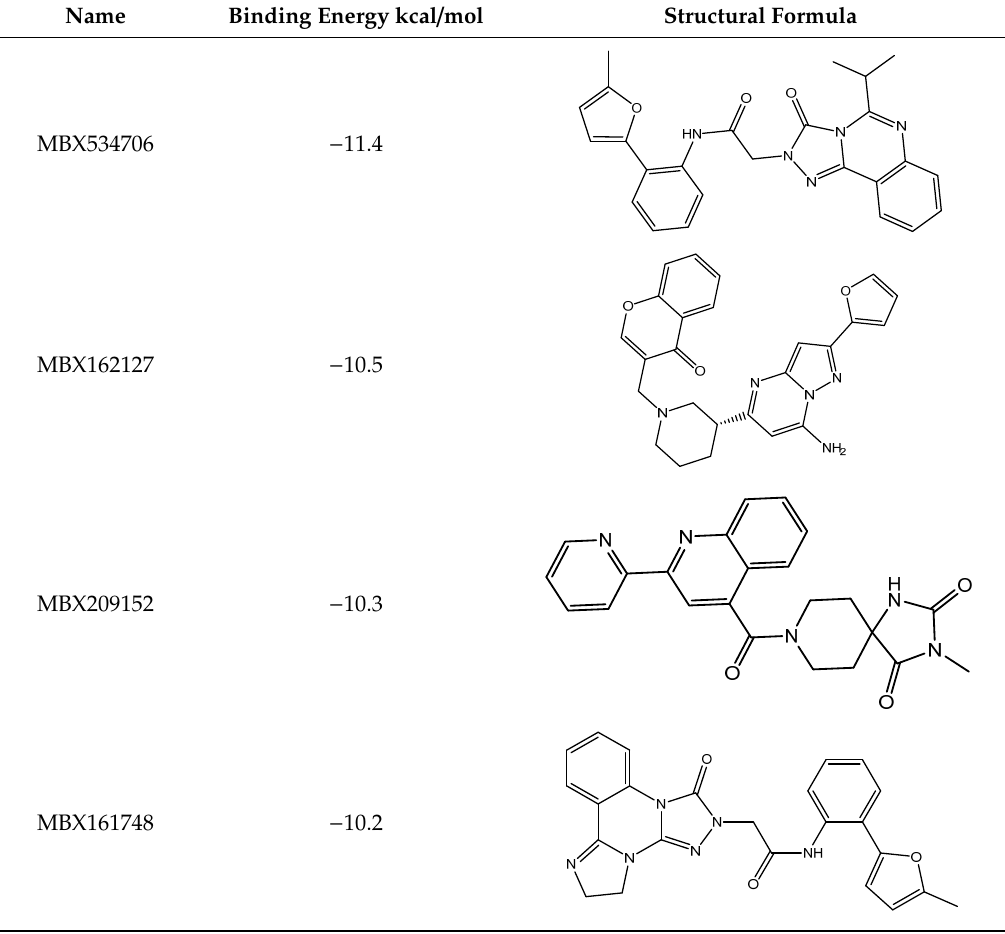
Table 3. Six top-ranked molecules with binding energies less than − 10.0 kcal /